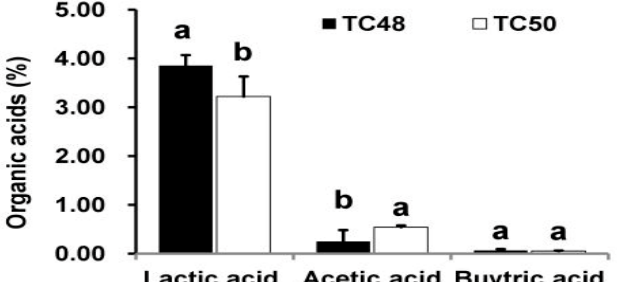
Figure 2. Organic acids production in Man Rogosa and Sharpe agar medium (MRS) broth. Percentage of lactic acid ( A ), acetic acid ( B ) and butyric acid ( C ) in MRS broth quantified by HPLC. a and b means with different letters within a column are significantly different at the 5% level.